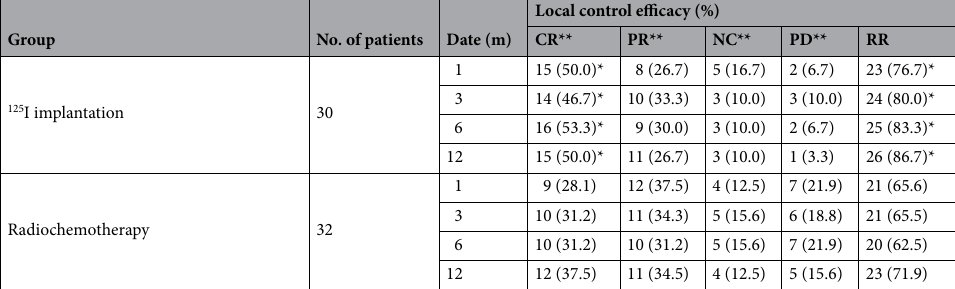
Table 2. Comparison of the response rate of patients treated with 125 I implantation with radiochemotherapy. Data in parentheses are percentages. ** CR complete response, PR partial response, NC no change, PD progressive disease, RR indicates the percentage of patients with response, i.e. RR = PR + CR. * P < 0.05 versus radiochemotherapy group.